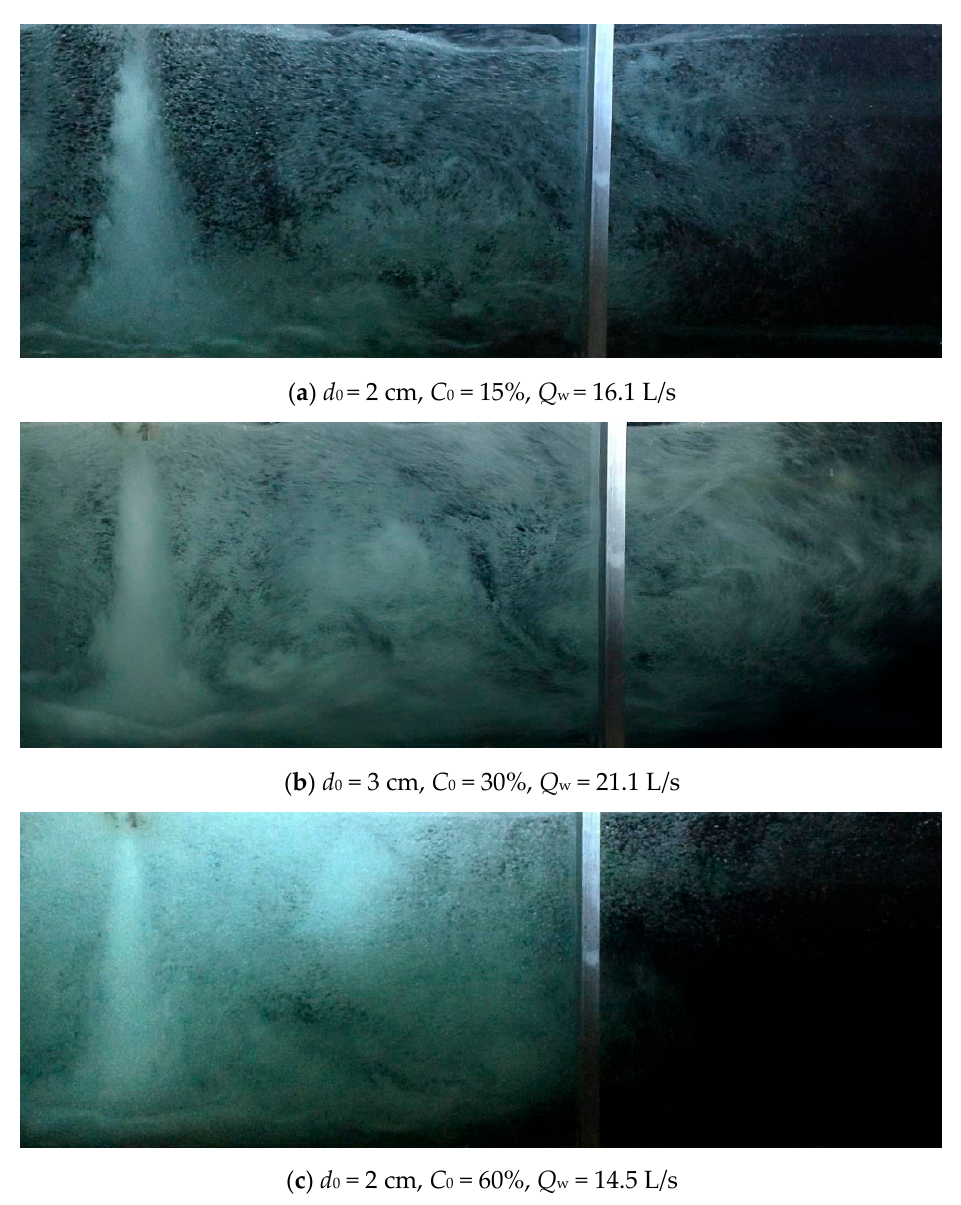
Figure 6. Air concentration distribution in the plunge pool.